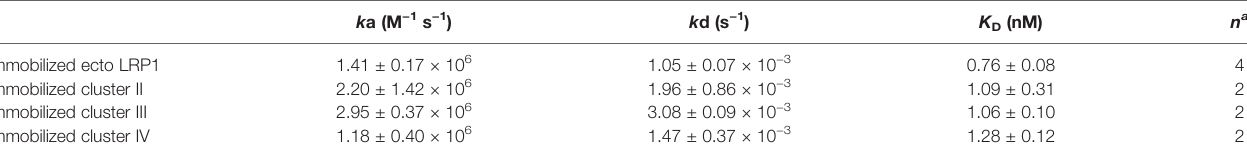
Values are expressed as means ± SE. n a Number of separate